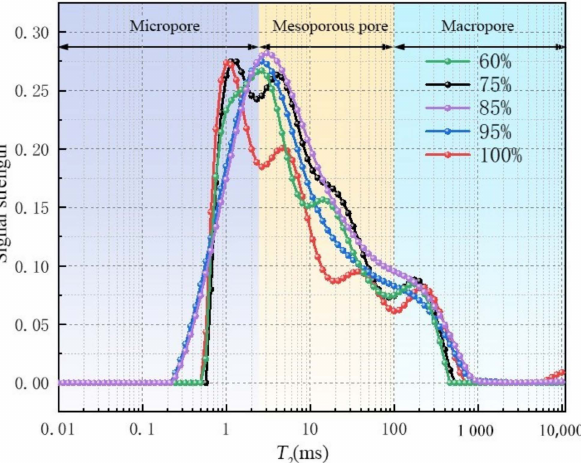
Figure 8. NMR T 2 distribution of sandstone with different saturation after